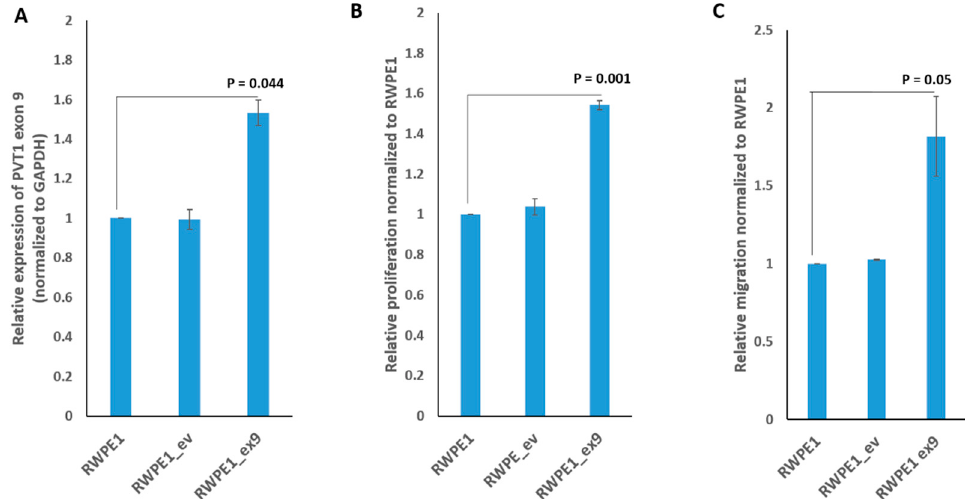
Figure 2. PVT1 exon 9 stable cell line induces gene expression, prostate epithelial cell proliferation, and migration. ( A ) PVT1 exon 9 expression, ( B ) cell proliferation, ( C ) cell migration. Data are presented as mean +/ − standard error of the mean (SEM). All the criteria for signi fi cance were set at p < 0.05. All experiments were done three different times. qPCR was performed in quadruplicates, using RNA from cells from three different passages.